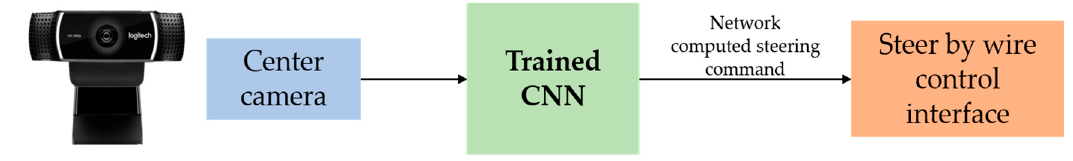
Figure 13. Diagram for the prediction of the steering wheel angle of the vehicle.